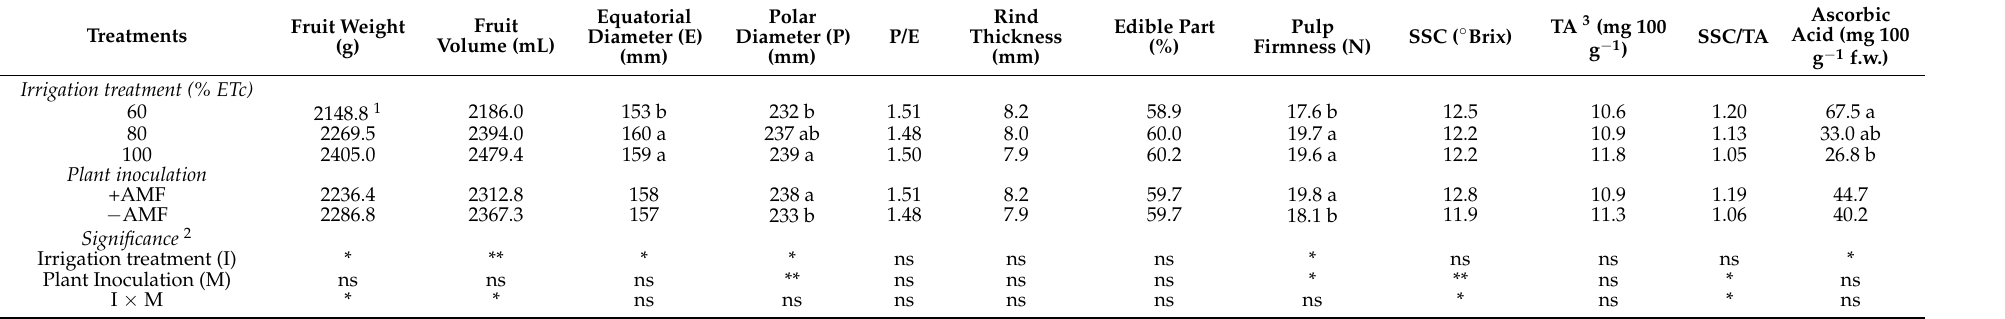
Table 4. Effect of irrigation treatments and plant inoculation with arbuscular mycorrhizal fungi (AMF) on melon fruit characteristics during two years of experiments (SSC: soluble solid content; TA: titratable